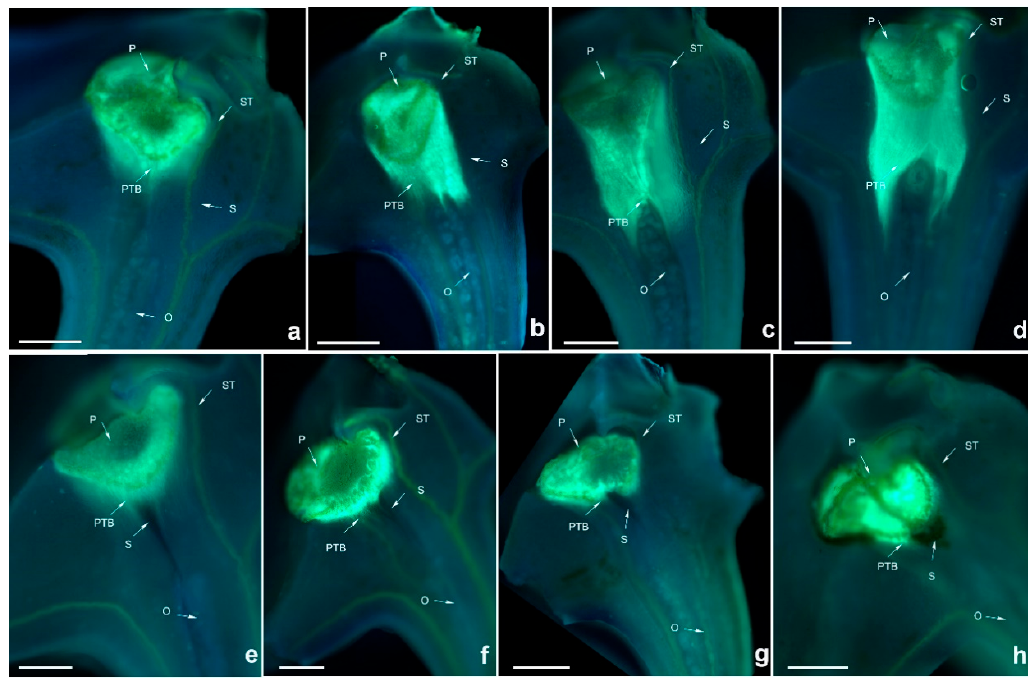
Figure 7. Growth of pollen tubes after self- and cross-pollination of Dendrobium moniliforme . P: pollinium; ST: stigma; PTB: pollen tube bundle; S: style; O: ovary. ( a ) 48 h after cross-pollination; ( b ) 72 h after cross-pollination; ( c ) 96 h after cross-pollination; ( d ) 120 h after cross-pollination; ( e ) 48 h after self-pollination; ( f ) 72 h after self-pollination; ( g ) 96 h after self-pollination; ( h ) 120 h after self-pollination. Bars = 100 µm.